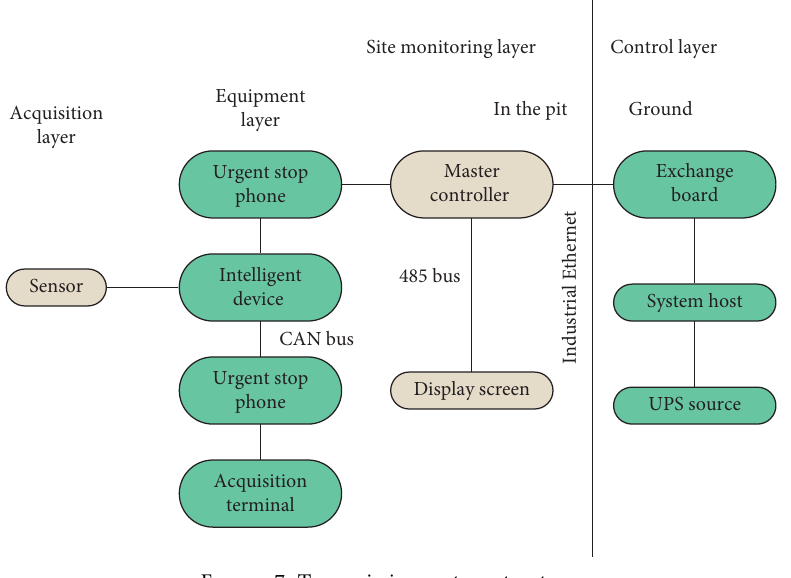
Figure 7: Transmission system structure.